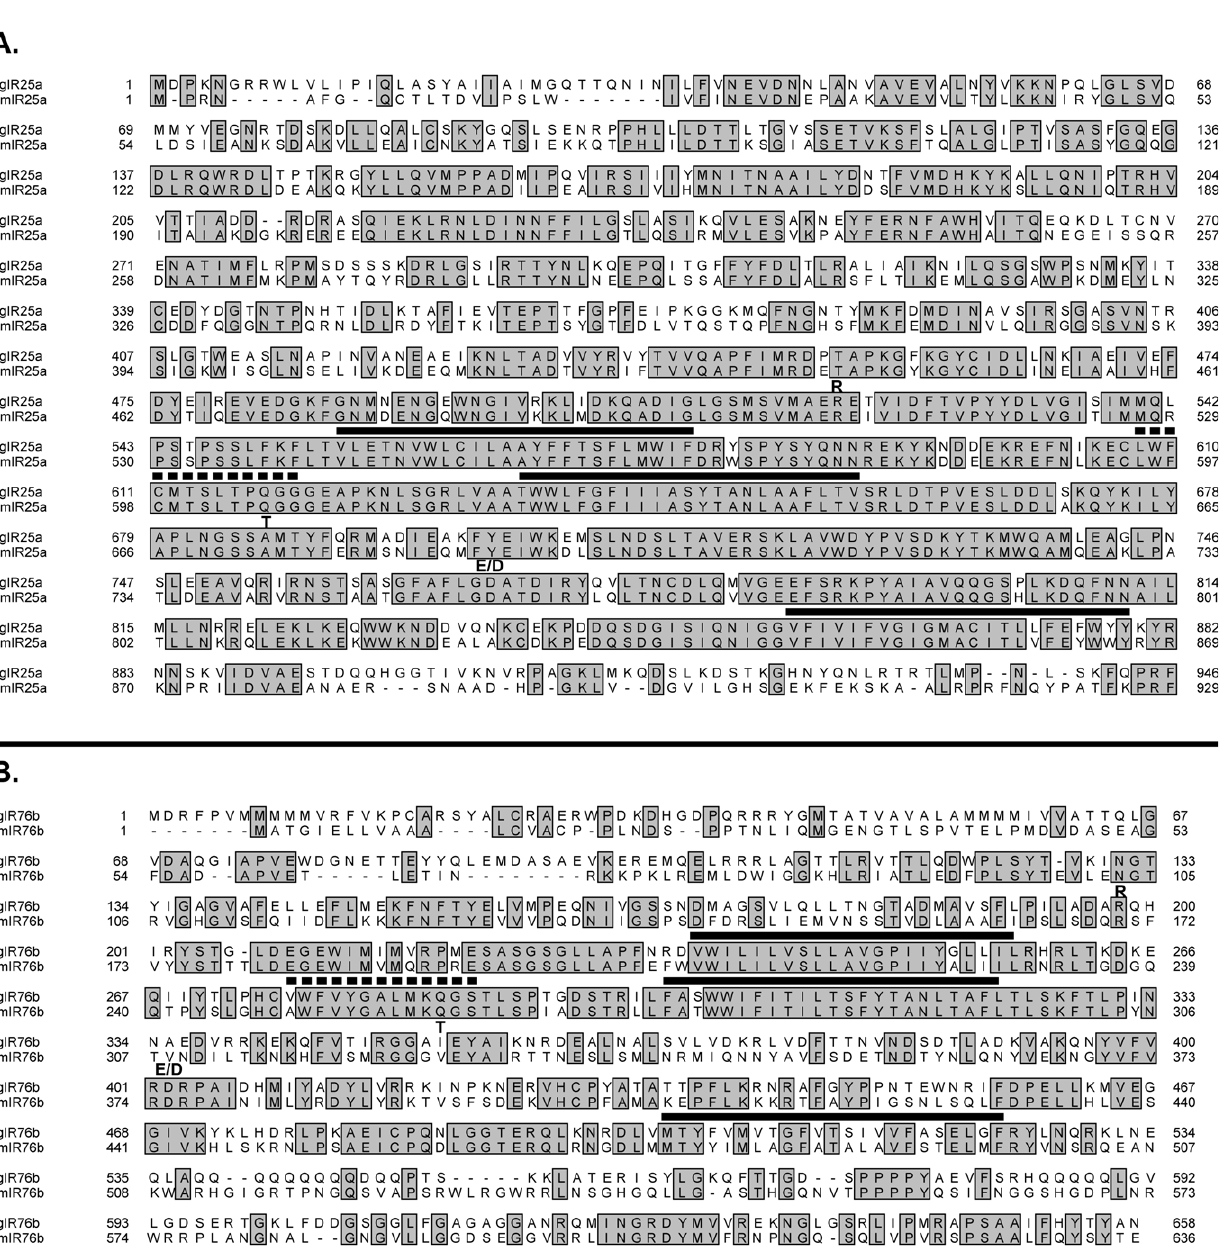
Figure 9. Representative alignments of AgIR and DmIR homologs. (A) IR25a peptide alignment. (B) IR76b peptide alignment. Amino acid sequences (single letter code) were aligned using ClustalX. Identical residues are shaded. Bold lines above residues indicate predicted transmembrane helices, while the dotted line above residues indicates the potential pore loop. Boldface letters represent amino acids arginine (R), threonine (T), or glutamic acid/aspartic acid (E/D) at positions that are found in known glutamate receptors. doi:10.1371/journal.pbio.1000467.g009 (Figure S2) and led to significant alterations in larval responses to butylamine (Figures 12 and 13B). Larval responses to butylamine were unaffected in AgOr7 knockdowns and by microinjection of non-specific siRNAs or buffer-alone controls (Figures 12 and 13B).